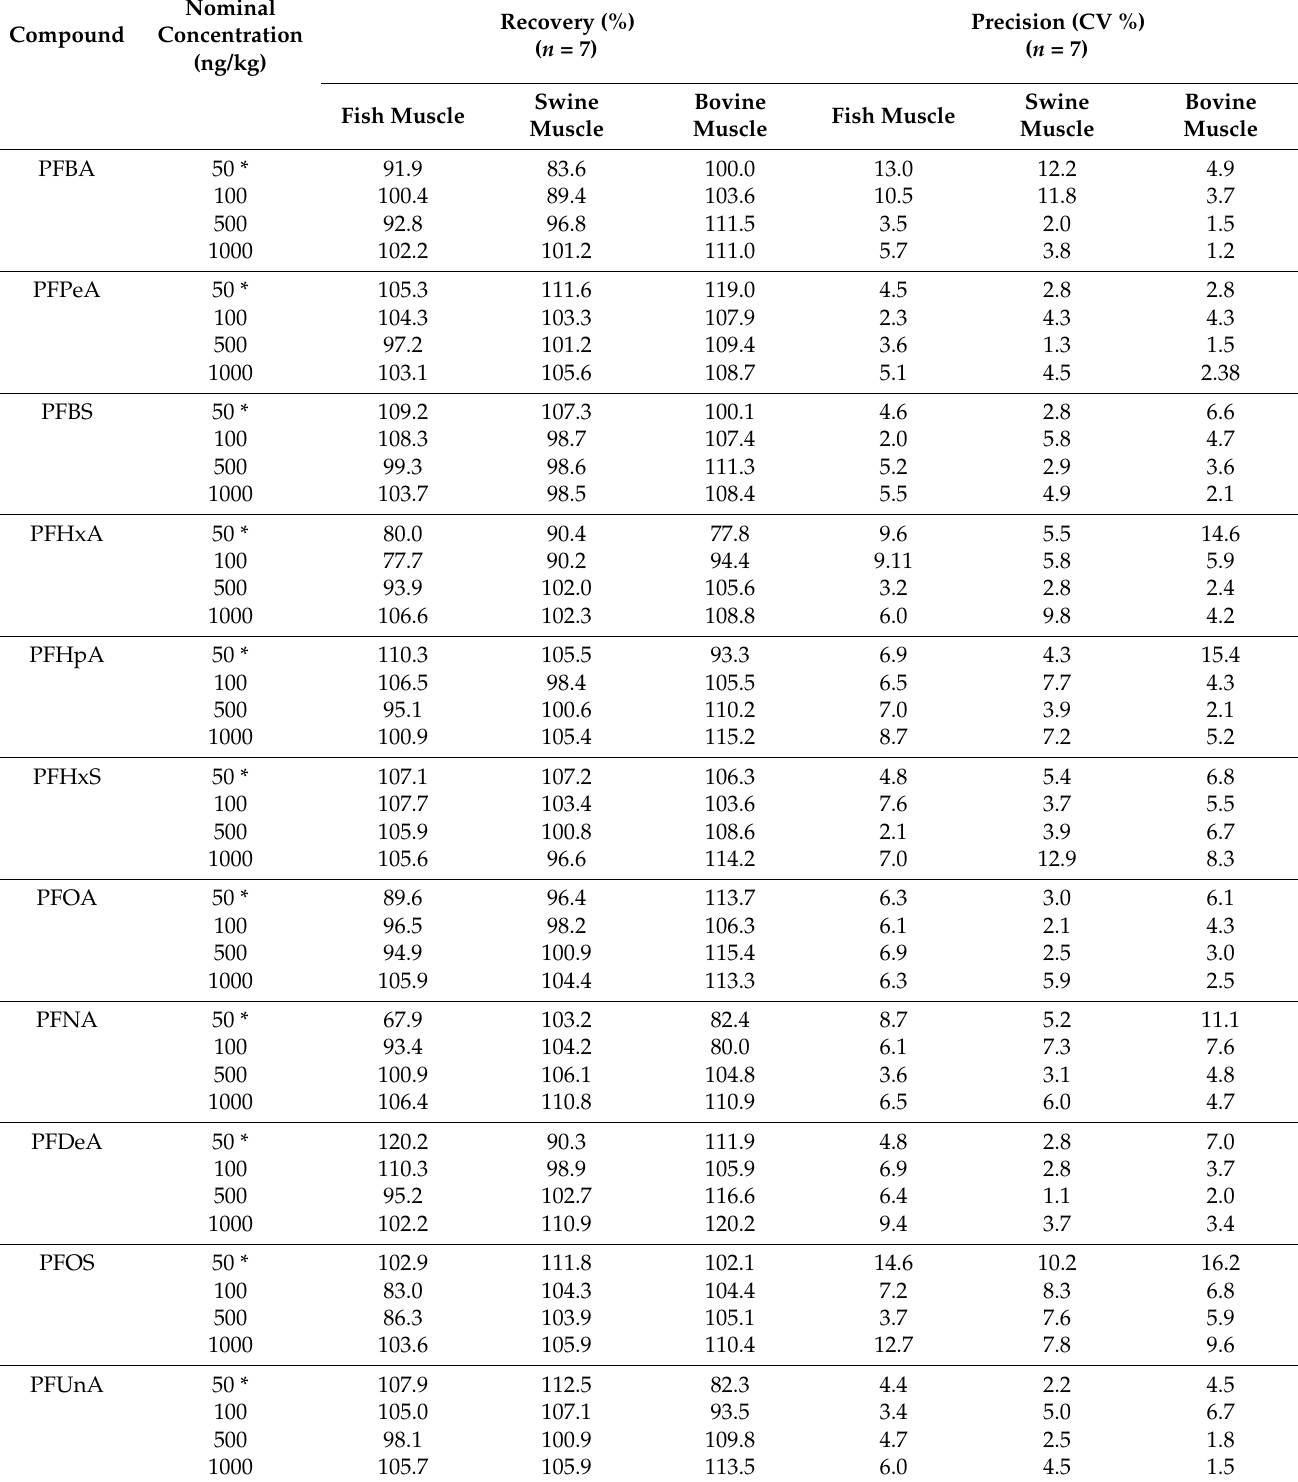
Table 2. Method recovery and repeatability in fish muscle, swine muscle, and bovine muscle samples intraday measurements (one blank sample spiked with four different concentrations, seven replicates for each